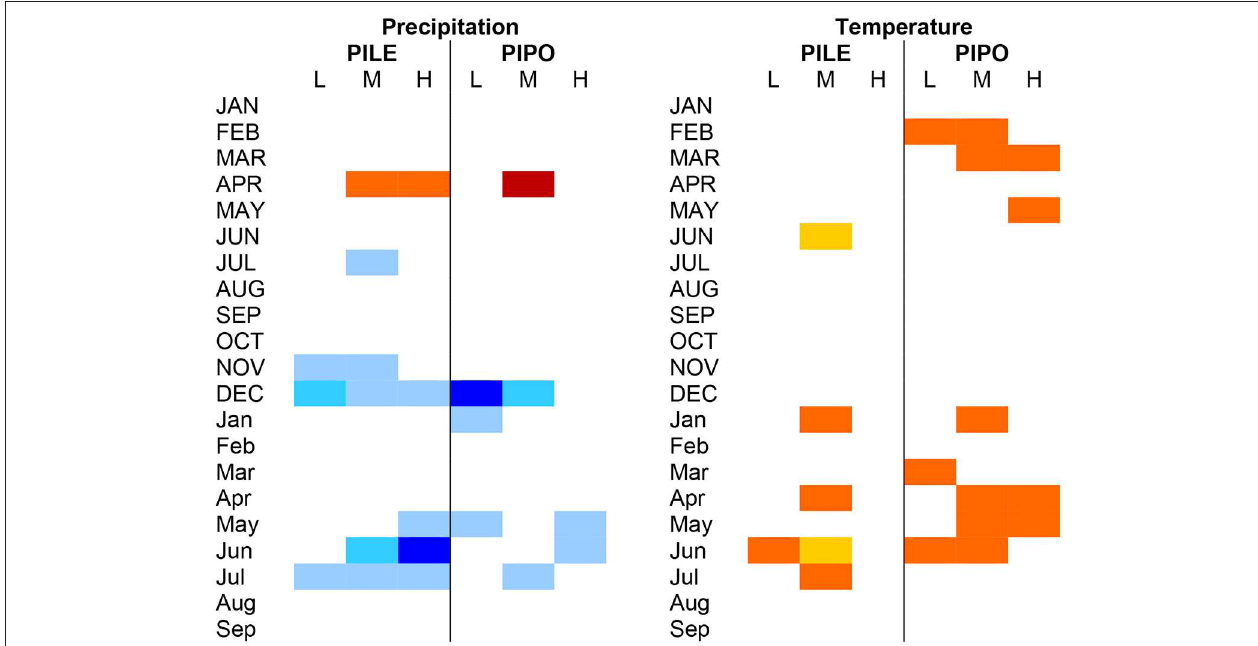
FIGURE 3 | Statistically significant correlations between ring width index values and monthly precipitation (Left) and temperature (Right) . Correlations were calculated for the previous year (JAN, FEB, etc.) and current year (Jan, Feb, etc.). Months with a correlation coefficient > |0.20| are shown in color. Darker shades of blue indicate increasingly positive correlations (max. value 0.42) and darker shades of red indicate increasingly negative correlations (min. value − 0.33).